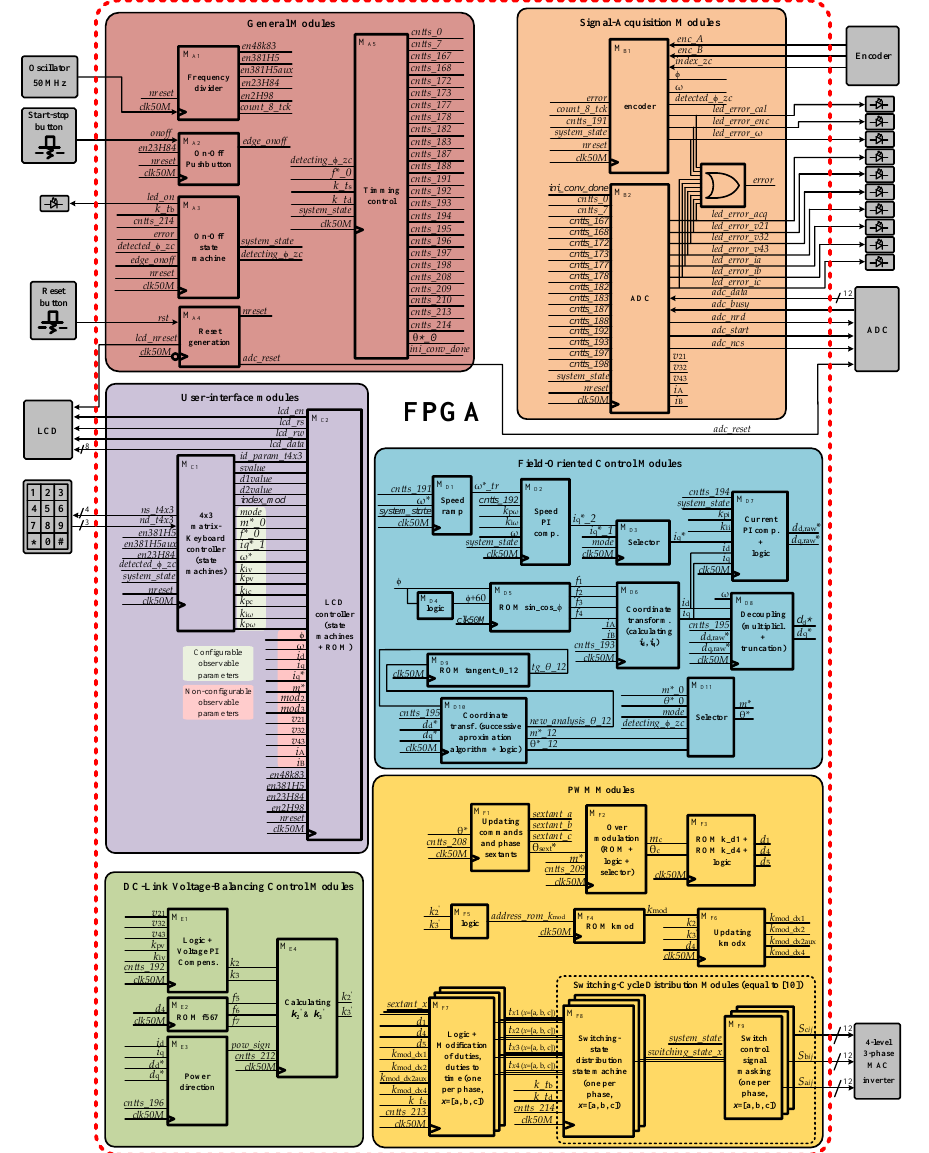
Figure 3. FPGA-controller design overview.